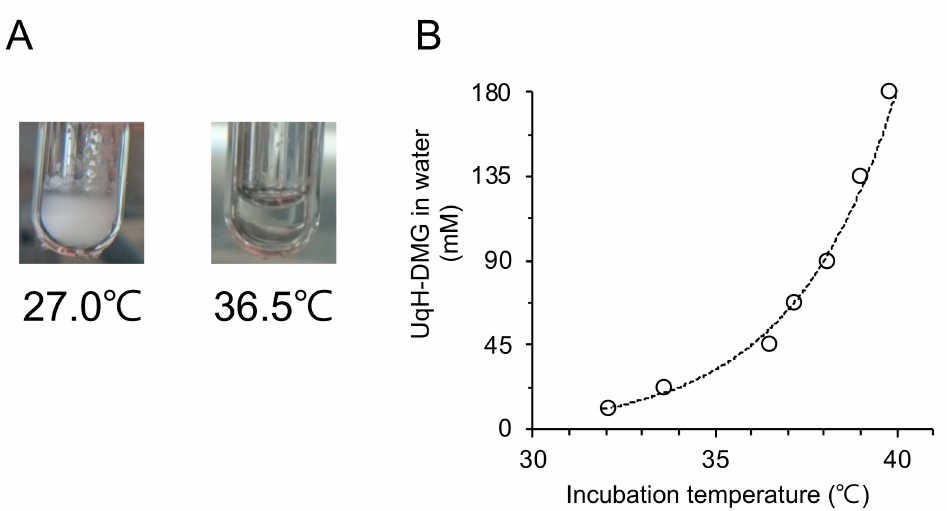
Figure 2. Influence of incubation temperatures on the solubility of UqH-DMG. ( A ) Representative photographs of 45 mM of UqH-DMG in water at 27.0 ◦ C and 36.5 ◦ C. ( B ) Solubilizing points of UqH-DMG in water versus incubation